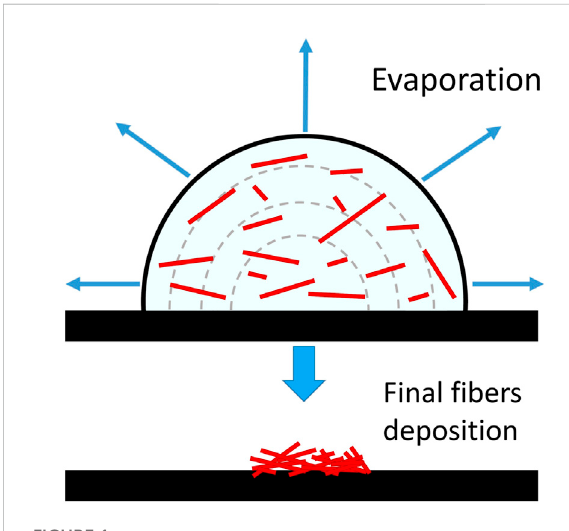
FIGURE 1 The deposition process of small particles from an evaporating solution on a hydrophobic surface with a negligible drop-surface interaction (redrawn from Macis et al., 2018).